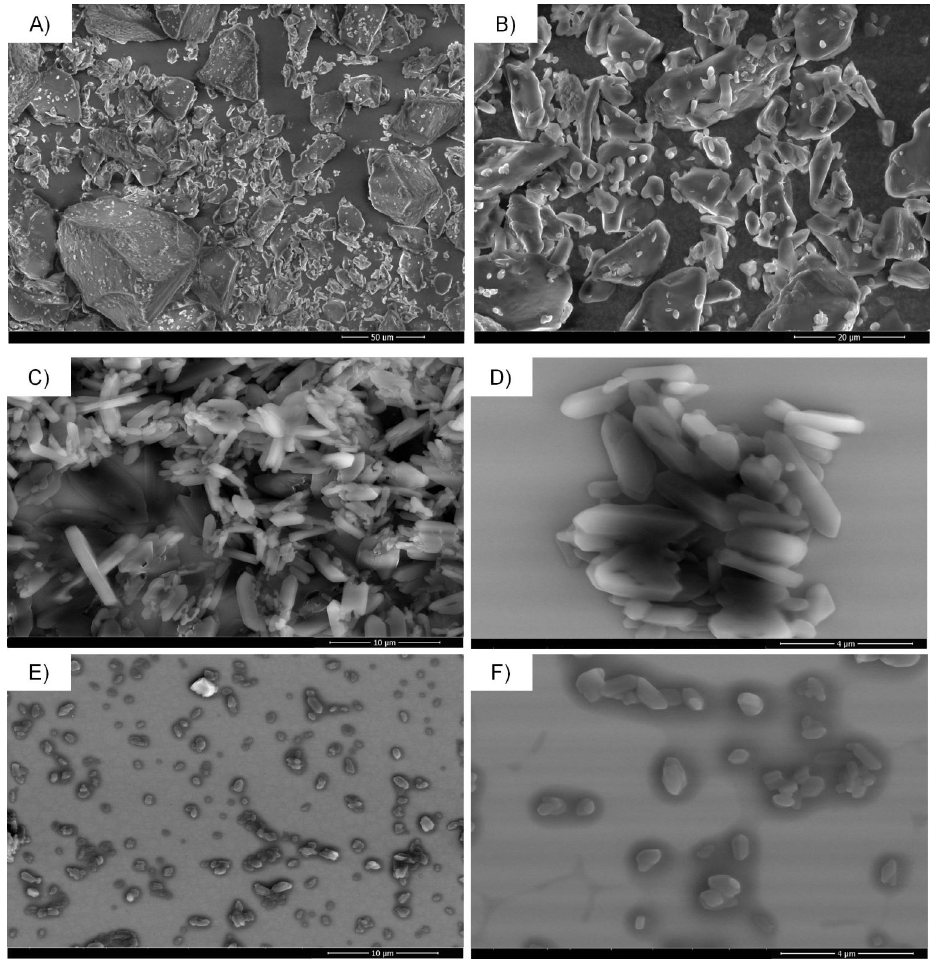
Figure 10. Scanning electron microscopy ( SEM) images of raw, unprocessed cilostazol powder ( A , B ), microcrystals ( C , D ) and nanocrystals ( E , F ). ( A ) magnification 1500×, scale bar 50 µm; ( B ) magnification 5000×, scale bar 20 µm); ( C , E ) magnification 10,000×, scale bar 10 µm; ( D , F ) magnification 30,000×, scale bar 4 µm.